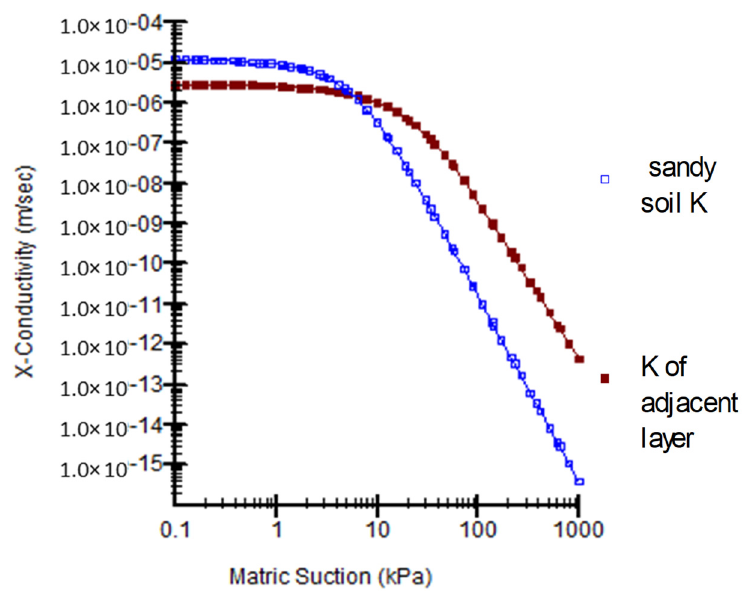
Figure 4. Hydraulic conductivity functions of the main sandy soil and adjacent clay deposit layer of the the canal.